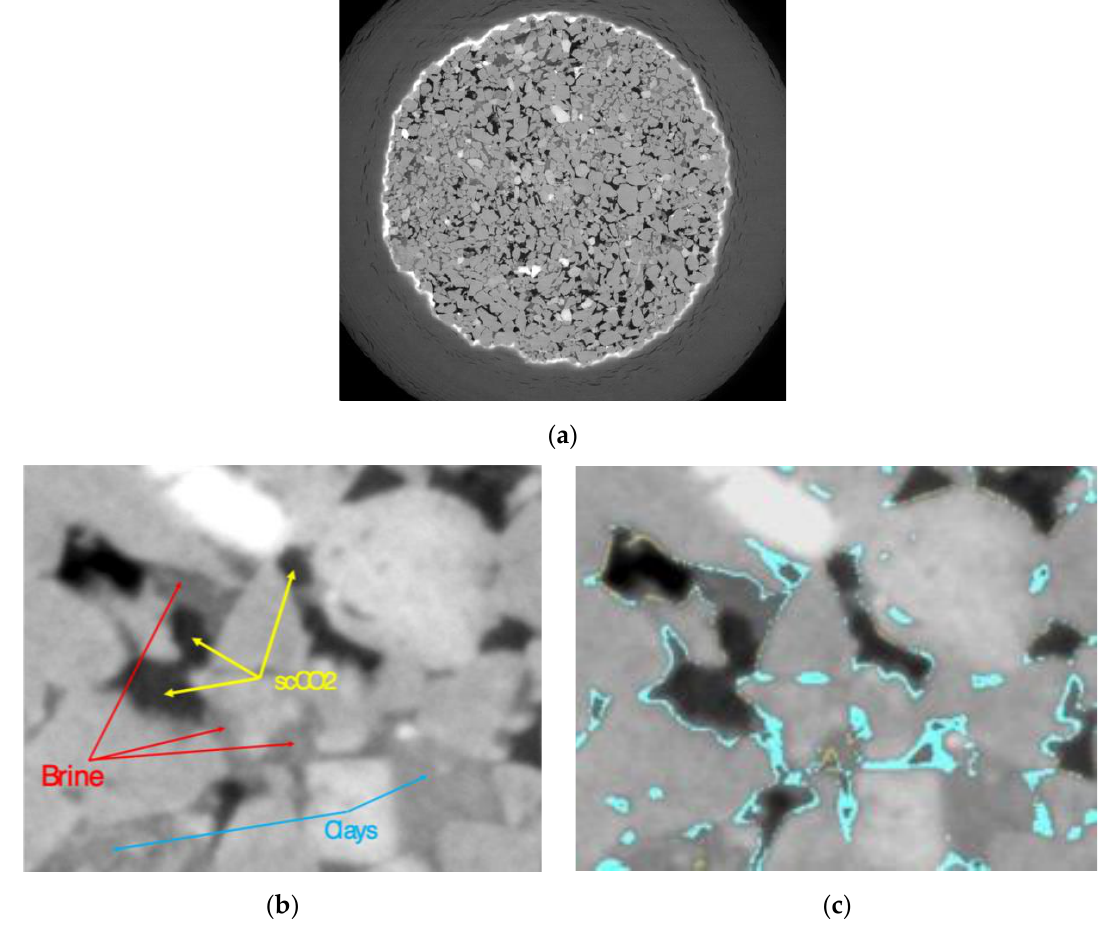
Figure 2. Influence of the segmentation performed with Ilastik vs. Otsu’s method: ( a ) raw recon- structed image, ( b ) description of a local zoom with an identification of phases, ( c ) local zoom with cyan voxels corresponding to voxels considered to represent porosity only using Ilastik (relative to Otsu’s thresholding), and yellow voxels corresponding to voxels considered to represent porosity only using Otsu’s thresholding (relative to Ilas tik).